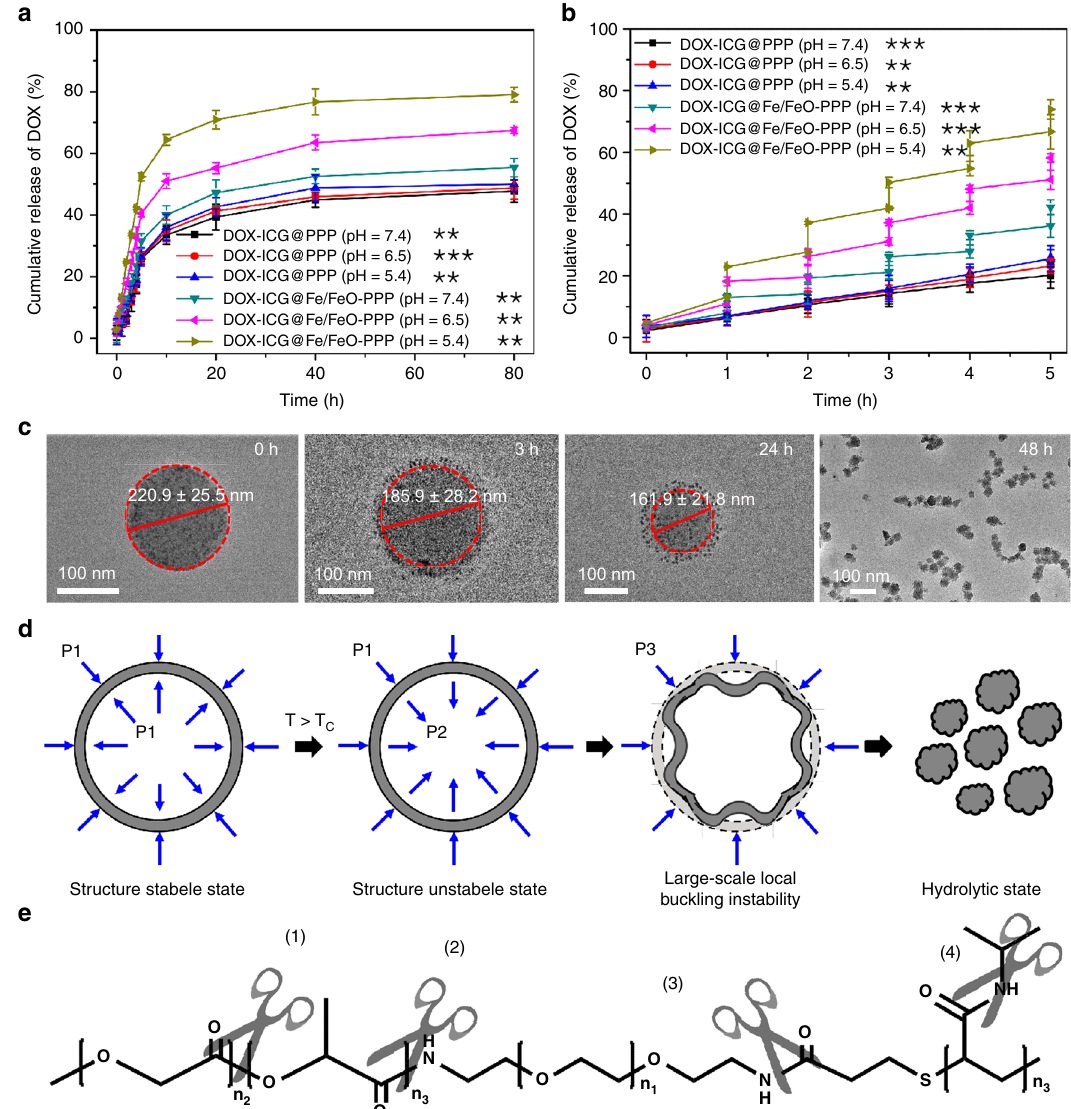
Fig. 4 DOX delivery evaluation of DOX – ICG@Fe/FeO – PPP nanocapsules. a DOX release curves of DOX – ICG@PPP nanocapsules and DOX –